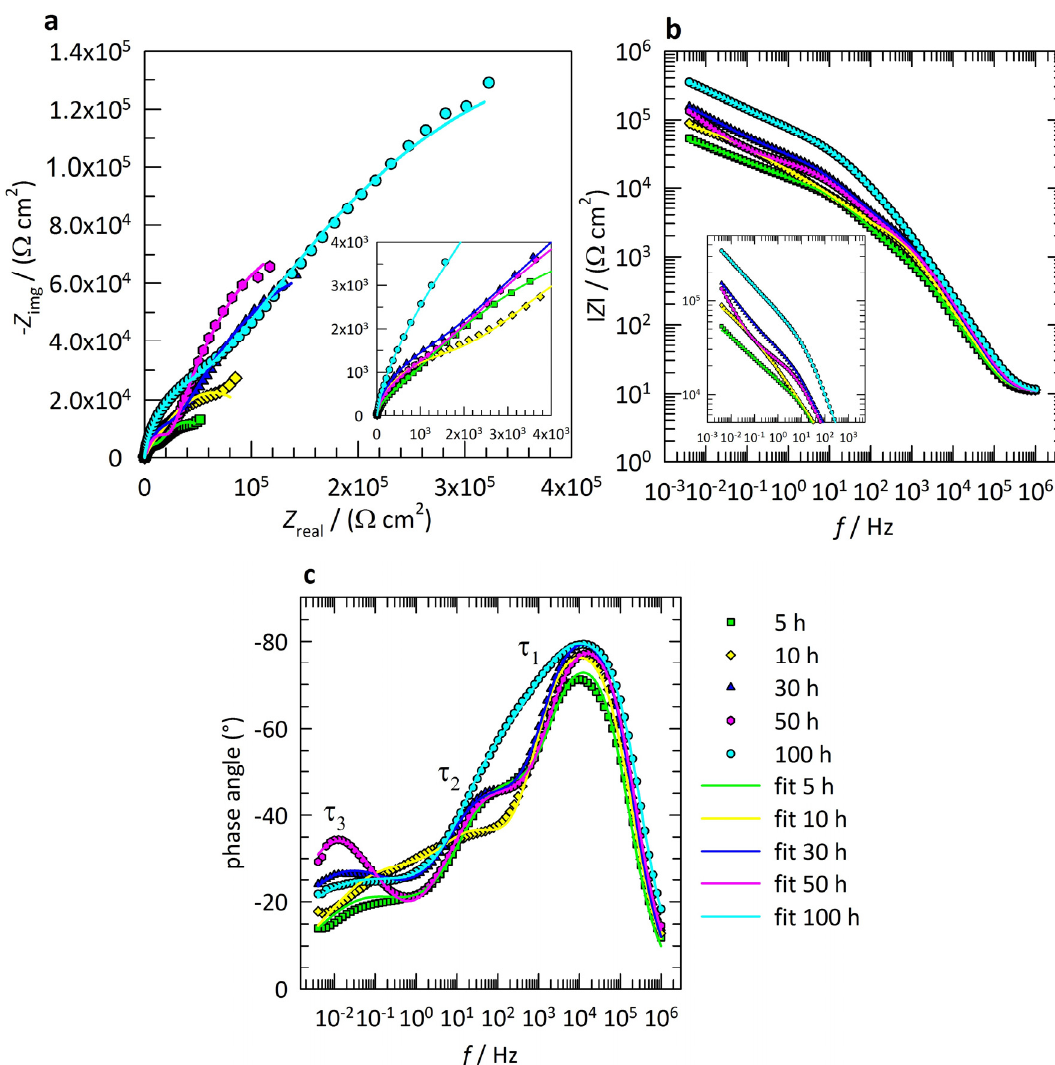
Figure 5. ( a ) Nyquist and ( b , c ) Bode plots of the copper samples after 5, 10, 30, 50, and 100 h of immersion in 3 wt.% NaCl solution containing 1 mM 2PhI. The measured EIS response is given in dotted symbols, while a solid line is used for the fitted results.